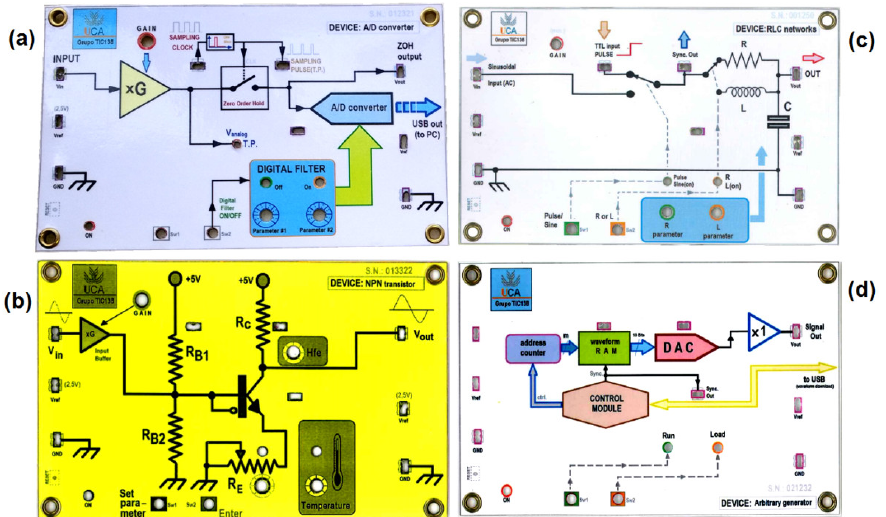
Figure 6. Several graphical-covers examples: ( a ) analog acquisition and basic digital processing experience; ( b ) the BJT amplifier; ( c ) first and second order low-pass filter convolution; ( d ) arbitrary waveform synthesis.